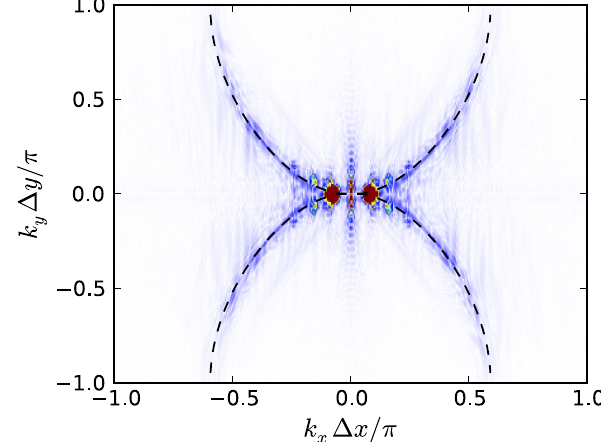
(cid:1) cB from y z (cid:1) x=(cid:7) ¼ x ¼ 0 x